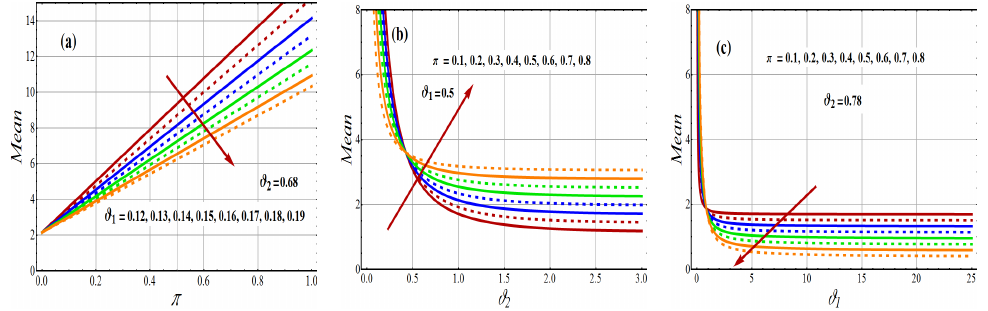
Fig. 2. In(cid:135)uences of (cid:133)rst and second components hrf ( h 1 ( t ) ; h 2 ( t )) and hrf of 2-CMSM ( h m ( t Figure 2 (a-h) shows various graphs of hrf of one and 2-CMSM h ( t values. It should be observed that parameter values were chosen at random until di⁄erent shapes could be obtained. An increasing trend can be seen in the hrf of each component distribution, while the hrf of 2-CMSM( (cid:21)(cid:1) ) shows monotonically increasing, decreasing, upside down bathtub, increasing decreasing-constant (IDC), behavior as shown in the (cid:133)gure. The hazard rate function the 2-CMSM( (cid:21)(cid:1) ) highlights its versatility over one component distribution of Shanker, exponential and Lindley, and two component of mixture of exponential and Lindley distributions. These as the data with decreasing and upside- down bathtub shapes.